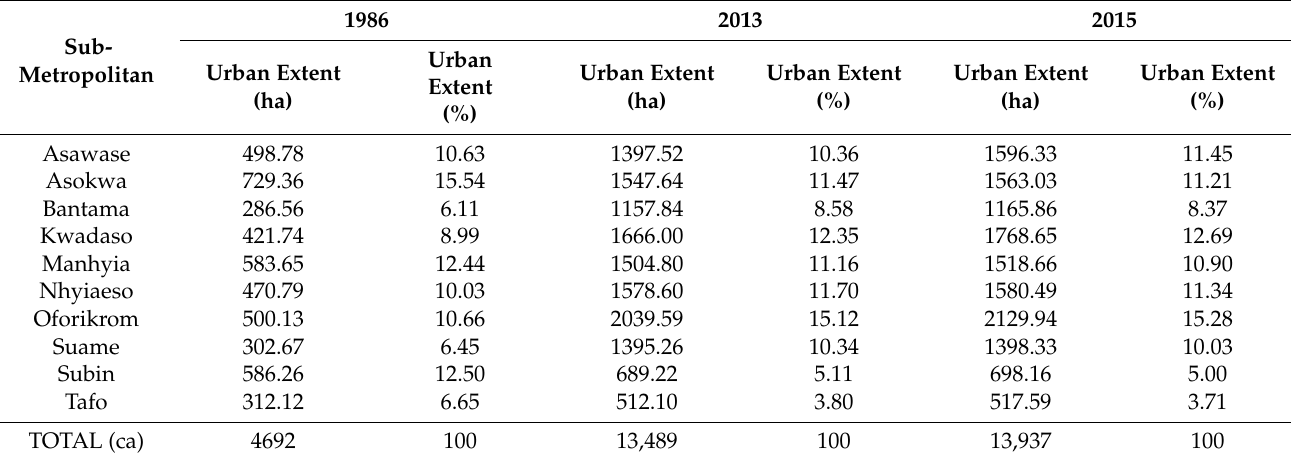
Table 7. Urban Extent in each sub-metropolitan